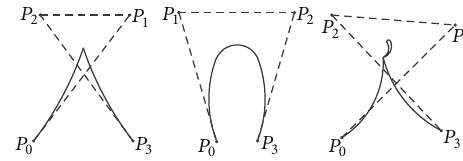
Figure 1: B´ezier curves of third degree and their control polygons.